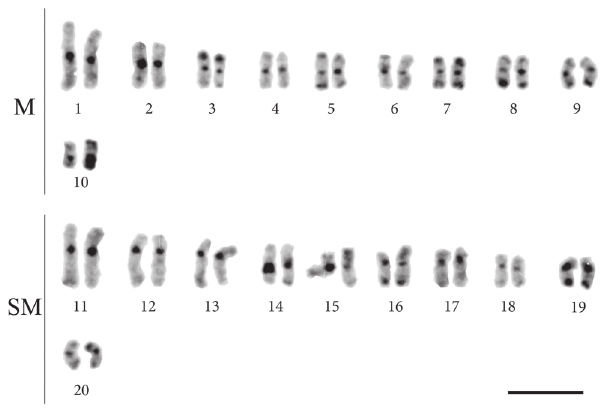
Fig. 2. C-banded karyotype of karyomorph C of Hoplias malabaricus , from lower Amazonas River. M - metacentric, SM - submetacentric. Bar =